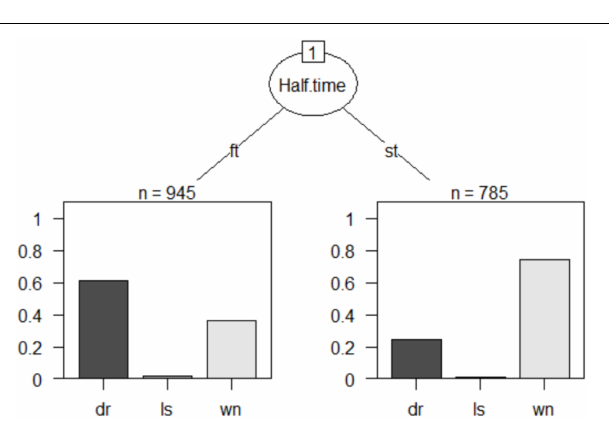
FIGURE 2 | Decision tree: successful teams